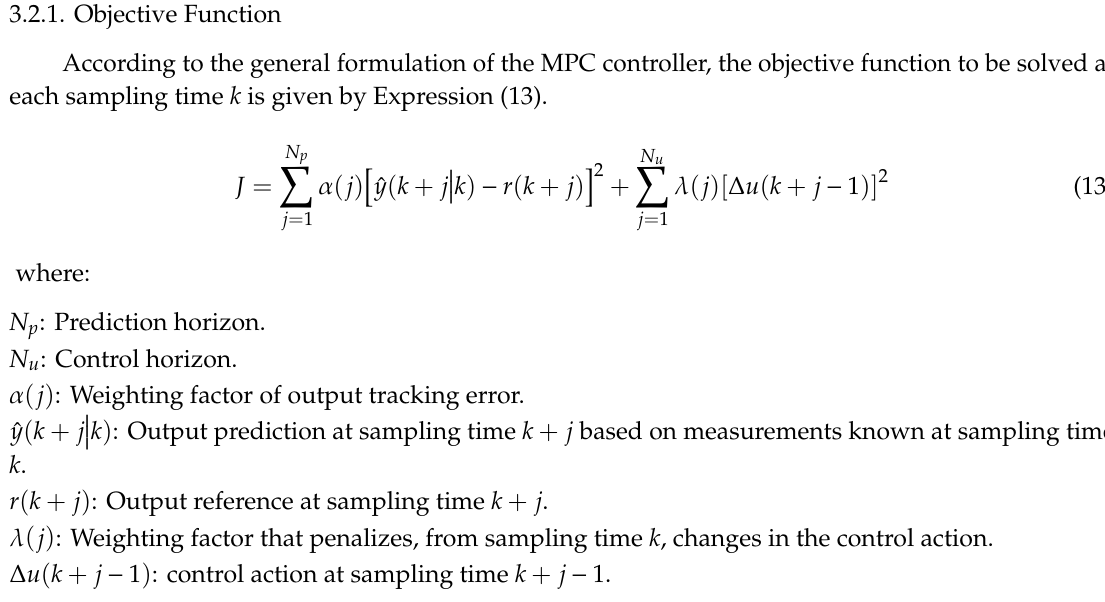
Figure 3. MPC controller architecture for the proposed multi-stack FC system.